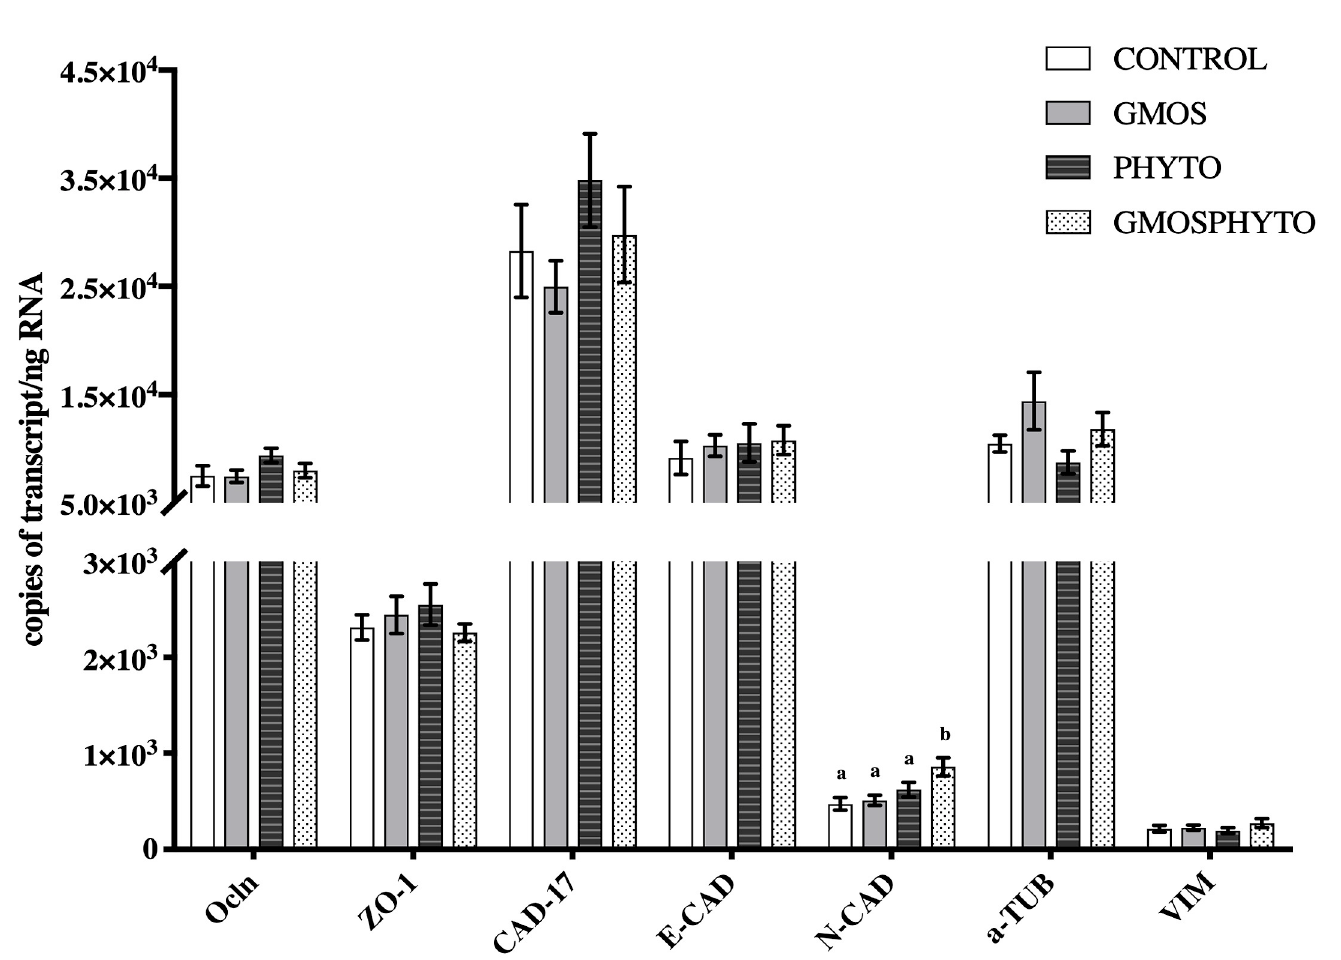
Fig 9. Absolute quantification of transcript copies of Ocln , ZO-1 , Cad-17 , E-Cad , N-Cad , a-Tub , and vim genes in European sea bass ( Dicentrarchus labrax ) posterior gut (mean ± SEM, n = 6 fish/diet). Functional low FM and FO diets were fed for 63 days. C (control diet), GMOS (5000 ppm galactomannan oligosaccharides), PHYTO (200ppm phytogenic), and GMOSPHYTO (5000 ppm galactomannan oligosaccharides+200ppm phytogenic). Different letters denote significant differences among dietary treatments (p � 0.05; one-way ANOVA; Tukey). Two-way ANOVA analyses found an increased (p � 0.10) absolute quantification of transcript copies for Ocln , N-Cad , and Cad-17 to PHYTO dietary supplementation in low FM and FO diets at the end of the feeding trial (F ocln = 3.299; p = 0.87; F N-Cad = 15.861; p = 0.001; F Cad-17 = 2.415; p = 0.130).). For detailed information see supporting information S1